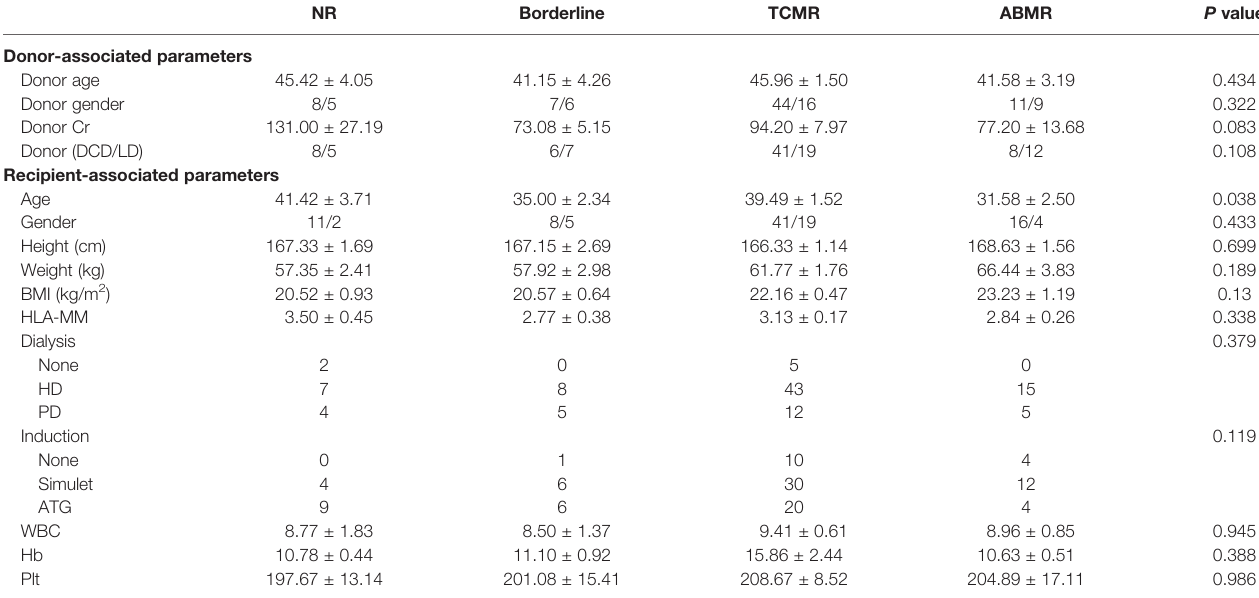
NR, no rejection; Borderline, borderline changes; TCMR, T cell-mediated rejection; ABMR, antibody-mediated rejection; DCD, donation of citizen death; LD, living donor; HLA-MM, HLA- mismatch; HD, hemodialysis; PD, peritoneal dialysis; ATG, anti-thymocyte globulin; WBC, white blood cell; Hb, hemoglobin; Plt, platelet. P value represents the difference between NR, borderline, TCMR, and ABMR using one-way ANOVA and chi-square